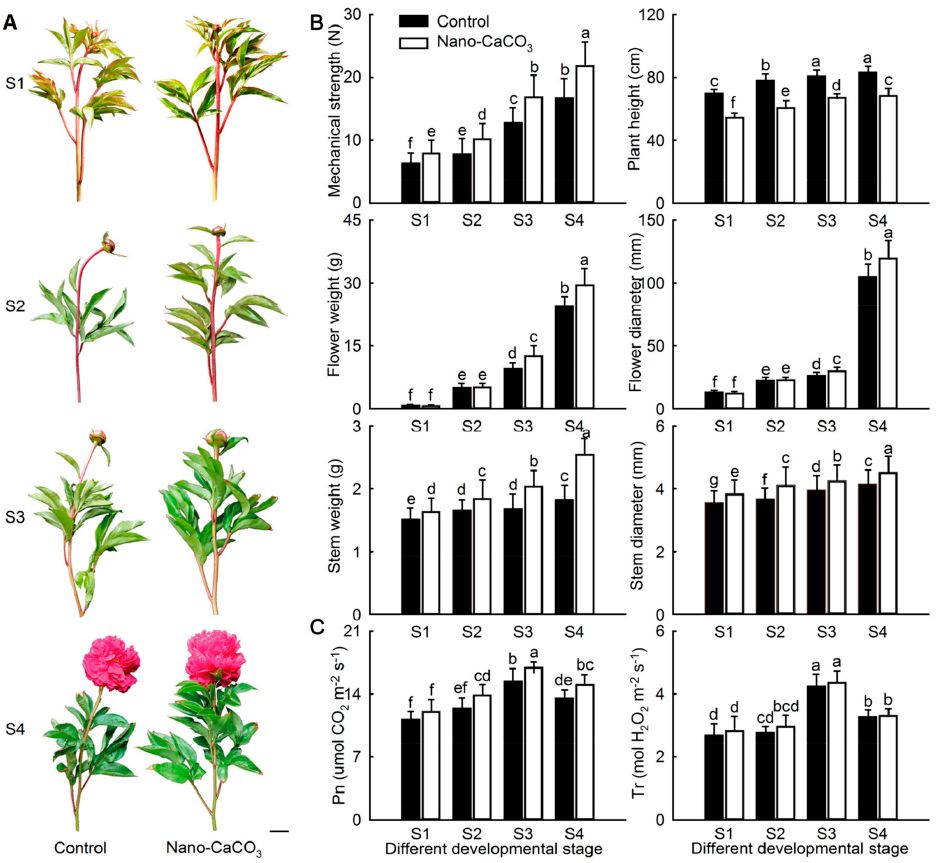
Figure 1. Effects of nano-CaCO 3 treatment on morphological indices and photosynthetic characteristics of P. lactiflora at four developmental stages. ( A ) Photographs of inflorescence stems; bar = 5 cm. ( B ) Morphological indices. ( C ) Photosynthetic characteristics. Pn , photosynthesis rate; Tr , Transpiration rate. The values represent the means ± SDs, and different letters indicate significant differences ( p < 0.05). S1, flower-bud stage; S2, pigmented stage; S3, unfold-petal stage; S4, full-flowering